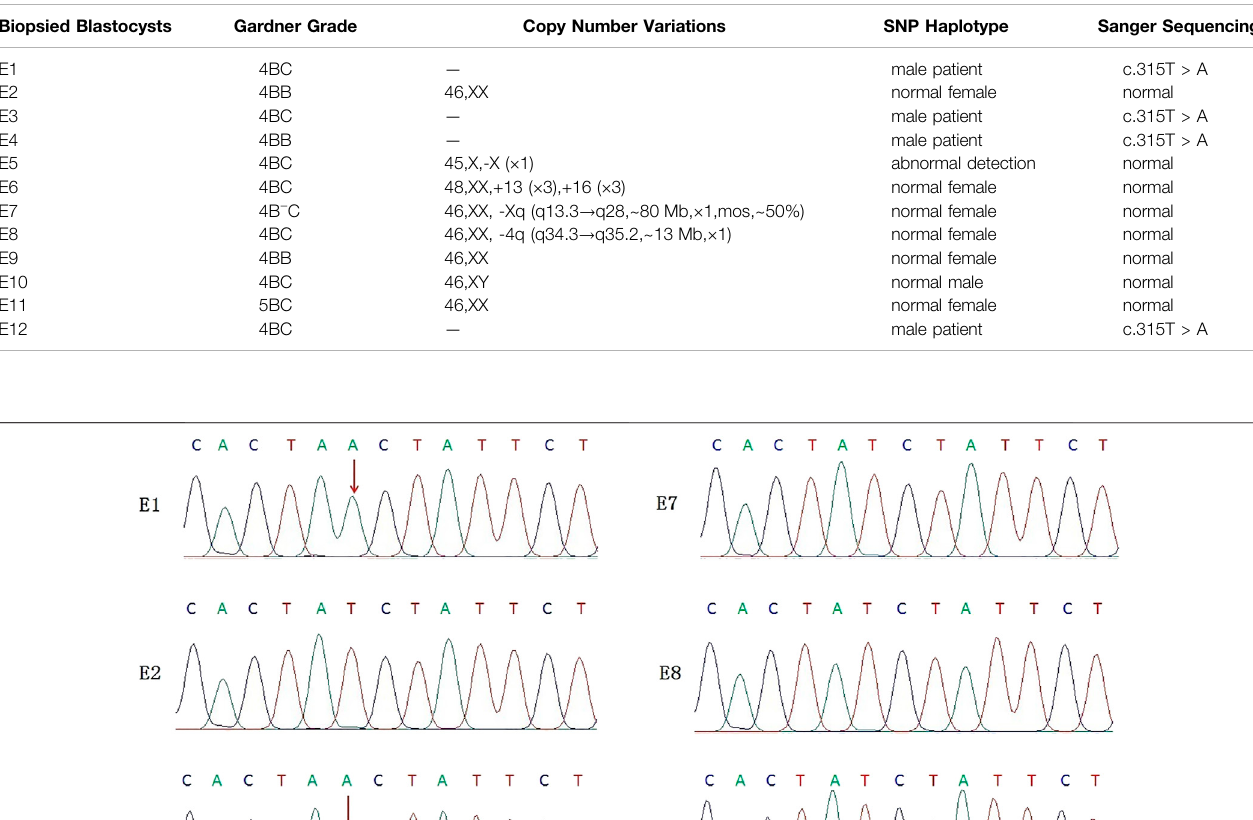
TABLE 1 | Summary of detection results.